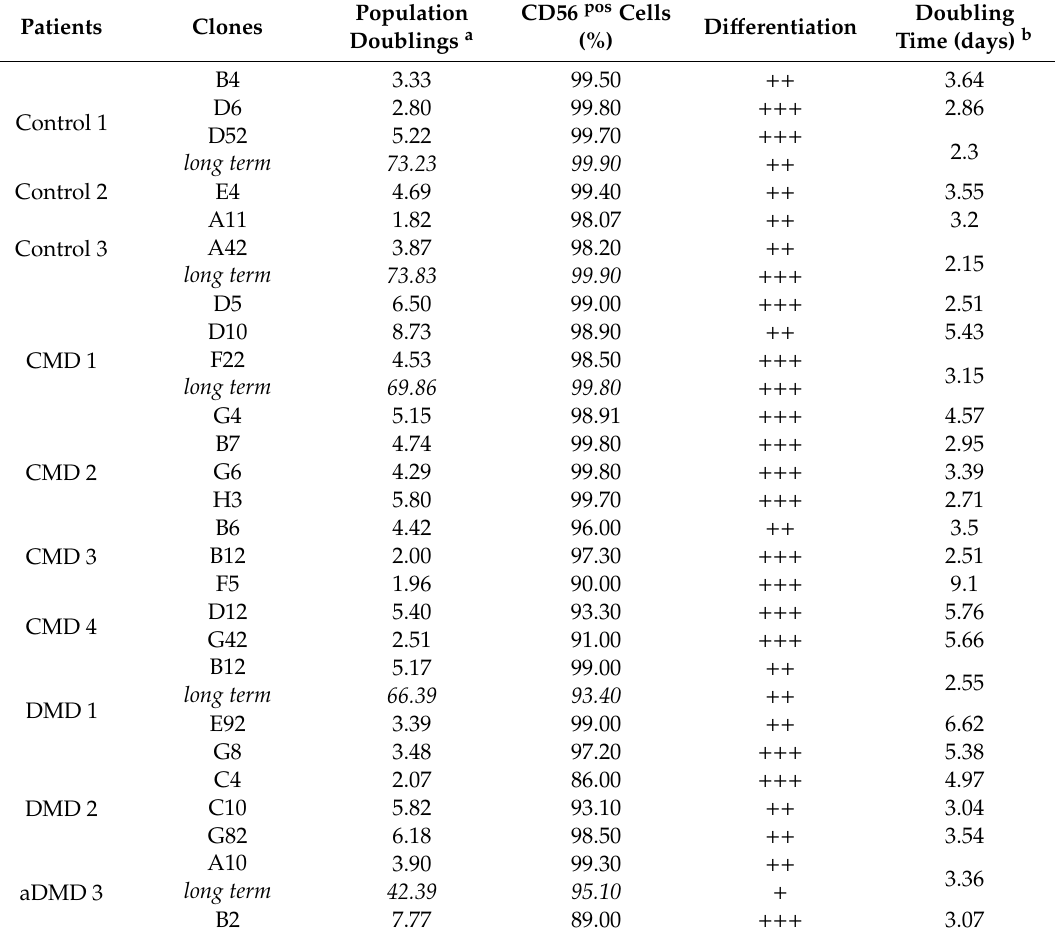
Table 3. Summary of characterized immortalized human myogenic stem cell